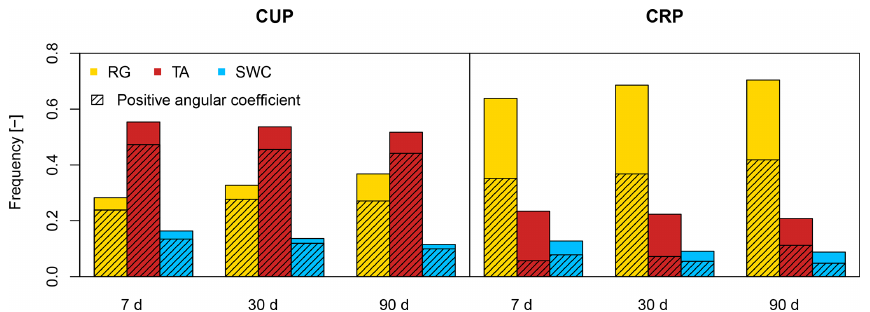
Figure 3. Frequency of the dominant variables plotted for the carbon uptake period (CUP) and carbon release period (CRP) at different temporal resolutions (7, 30 and 90d), and frequency of dominant variables with positive coefficients (dashed